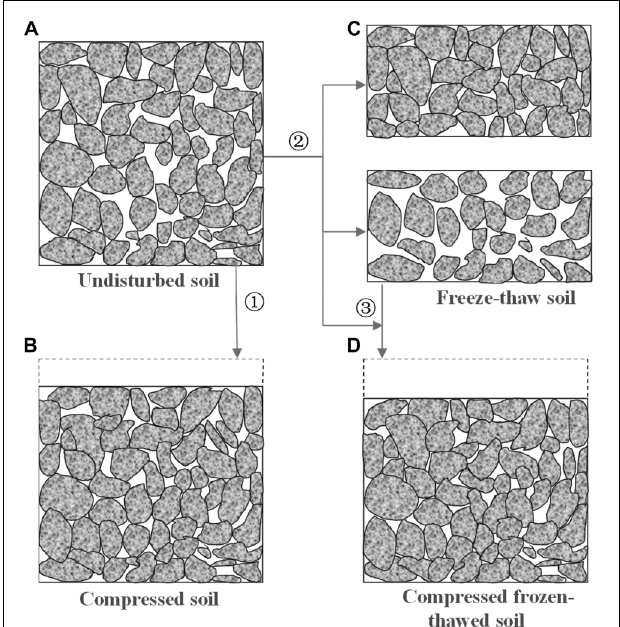
FIGURE 11 | Schematic of micro-pore changes in clay under freeze-thaw and compression ( (cid:192) consolidation test, (cid:193) freeze-thaw test, and (cid:194) consolidation test). (A) Undisturbed soil, (B) Compressed soil, (C) freeze-thaw, (D) Compressed frozen-thawed